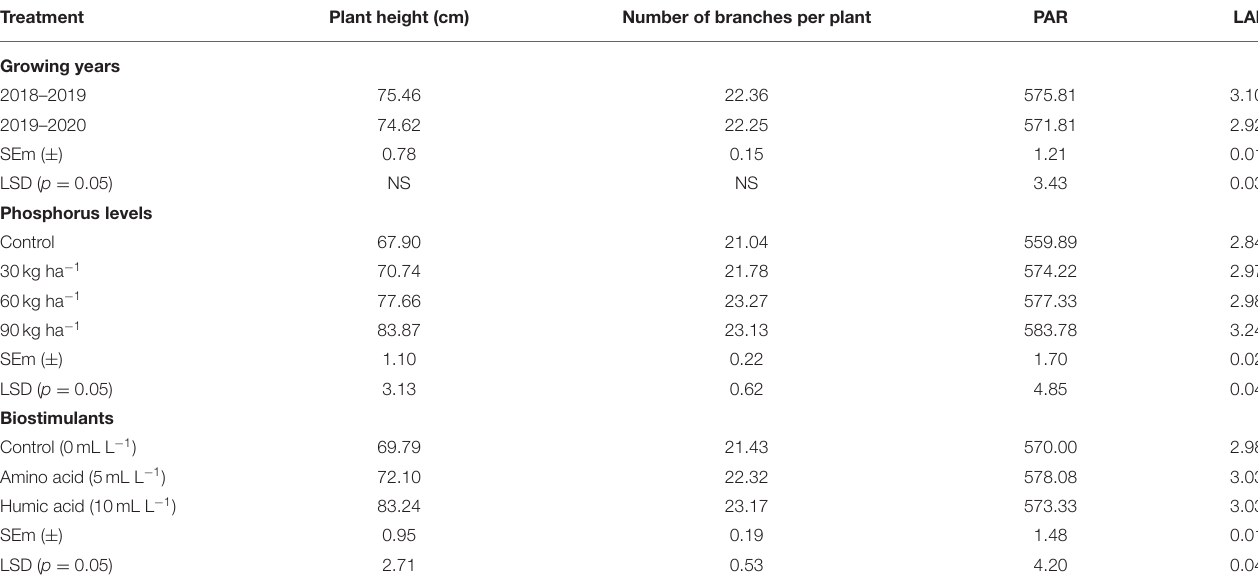
TABLE 2 | Growing years, phosphorus and biostimulant application influences plant growth and yield contributing attributes in M. chamomilla at harvest.